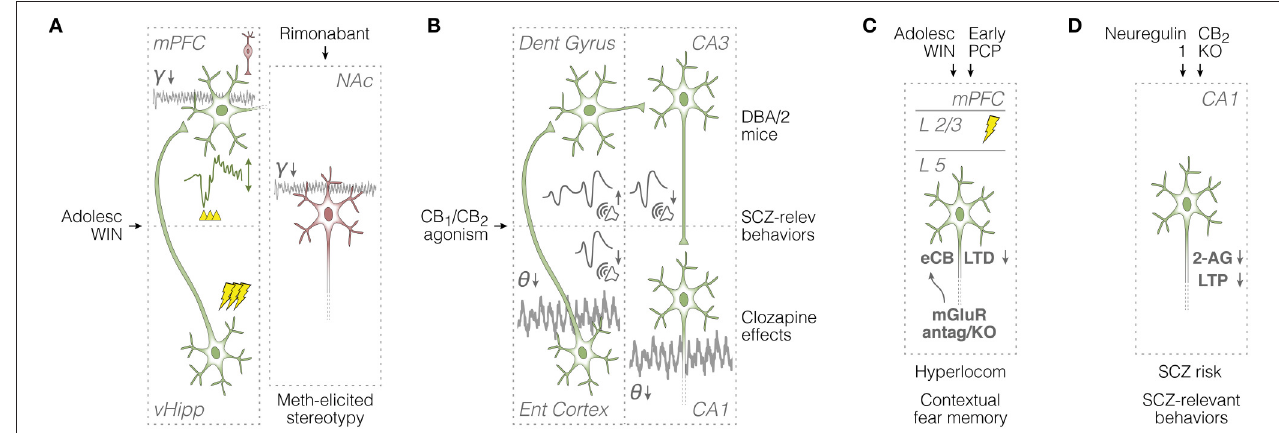
FIGURE 3 | Summary of in vivo field potential and in vitro synaptic plasticity studies in rodents. (A) Left: evaluation of mPFC responses (see voltage deflection) to vHipp train stimulation (see lightning icons), and the mPFC capacity to engage in ketamine-potentiated gamma oscillations (see spontaneous field potentials) after adolescent WIN treatment (Raver et al., 2013; Cass et al., 2014). Right: attenuating effects of rimonabant on methamphetamine-potentiated stereotypy and accumbal gamma oscillations ( Morra et al., 2012). Green and red neurons are glutamatergic and GABAergic, respectively. (B) Overall effects of cannabinoid agonists on spontaneous theta oscillations and auditory evoked potentials across entorhinal cortical and hippocampal circuits ( Dissanayake et al., 2008; Hajós et al., 2008), and relationships with schizophrenia-relevant mouse models and manipulations (Smucny et al., 2014). (C) In vitro assessment of mPFC synaptic plasticity and glutamatergic neurotransmission after adolescent WIN or early-life PCP exposure: association with schizophrenia-like symptoms ( Lafourcade et al., 2007; Jew et al., 2013; Lovelace et al., 2014, 2015). (D) In vitro assessment of CA1 synaptic plasticity and eCB neurotransmission: relationships with schizophrenia risk factors and cannabinoid receptor activation ( Du et al., 2013; Kim and Li, 2015; Li and Kim, 2016). 2-AG, 2-arachidonoyl-glycerol; adolesc, adolescent; antag, antagonism; dent, dentate; eCB-LTD, endocannabinoid long-term depression; ent, entorhinal; γ , gamma oscillations; hyperlocom, hyperlocomotion; KO, knockout; L, layer; LTP, long-term potentiation; meth, methamphetamine; mGluR, metabotropic glutamate receptors; mPFC, medial prefrontal cortex; NAc, nucleus accumbens; PCP, phencyclidine; relev, relevant; SCZ, schizophrenia; θ , theta oscillations; vHipp, ventral hippocampus; WIN, WIN